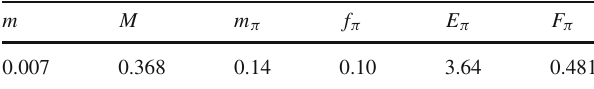
Salpeter equations yields the results listed here. (Dimensioned quanti- ties in